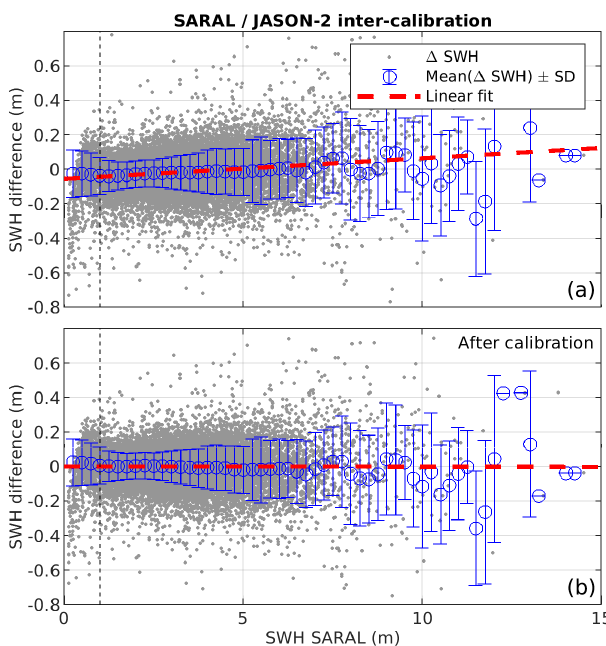
Figure 7. Residual of CRYOSAT-2 SWH − JASON-2 SWH as a function of CRYOSAT-2 SWH before (a) and after (b) calibration. The dashed red line is a linear fit through the